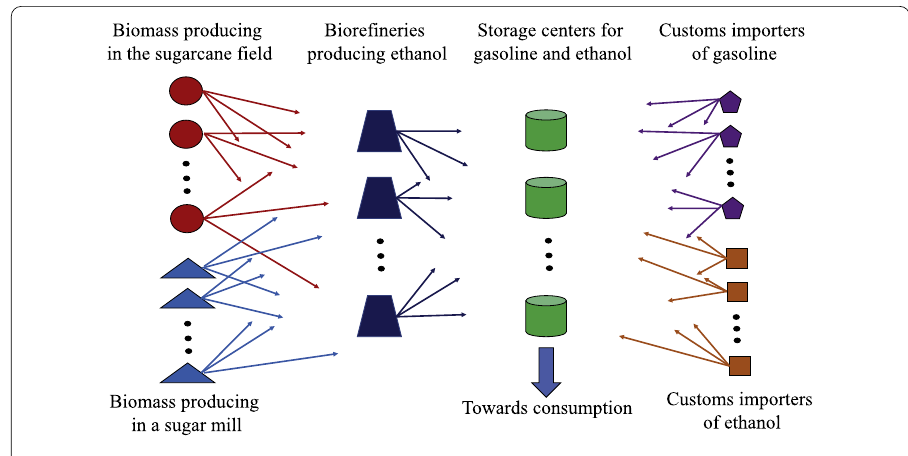
Figure 1 Graphical representation of the system